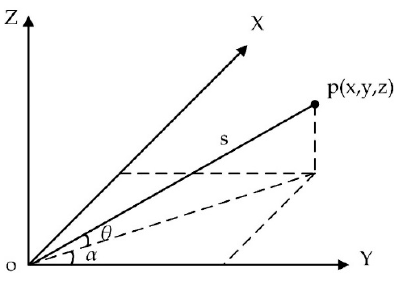
Figure 1. Observation principle of TLS.